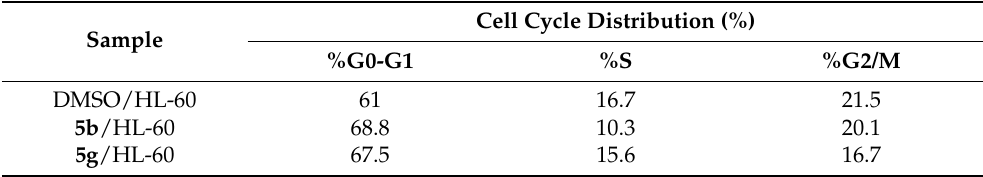
Table 3. Effect of compounds 5b and 5g on cell cycle distribution in HL-60 cells.